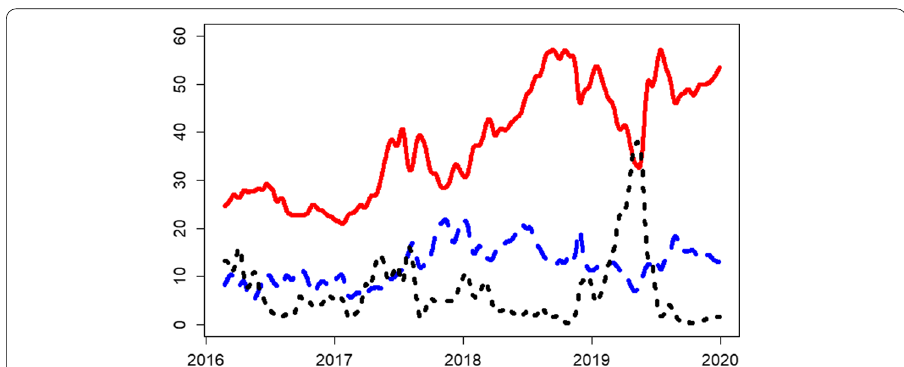
Fig. 6 Rolling-window based total return spillover index based on the BK approach. Note : 200 days rolling window, lag order 12 based on AIC. Short-run (0–5 days) is in red color; medium-run (6–56 days) is in blue color; long-run (more than 56 days) in black